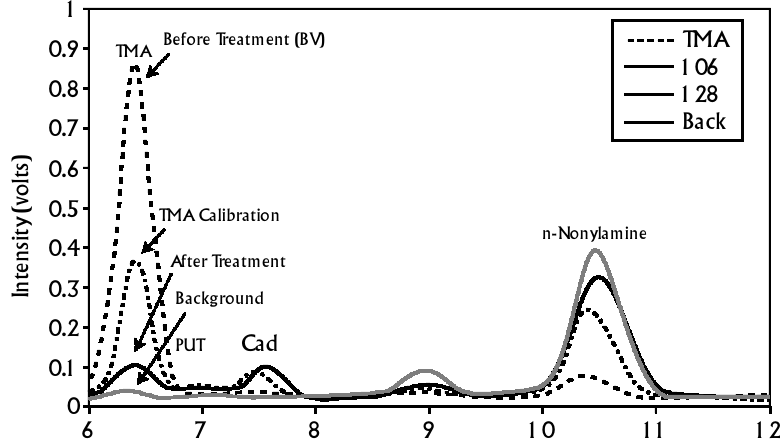
Figure 1 Ion mobility spectrogram of vaginal fluid in bacterial vaginosis (BV). TMA, trimethylamine; Put,